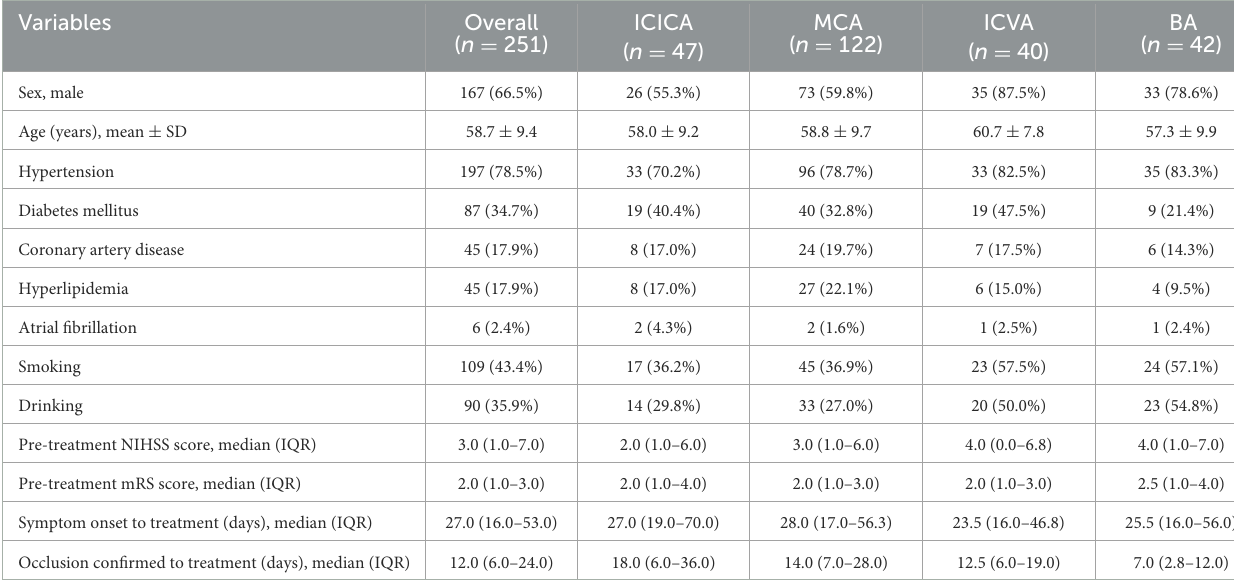
TABLE 1 Patients’ baseline demographic and clinical